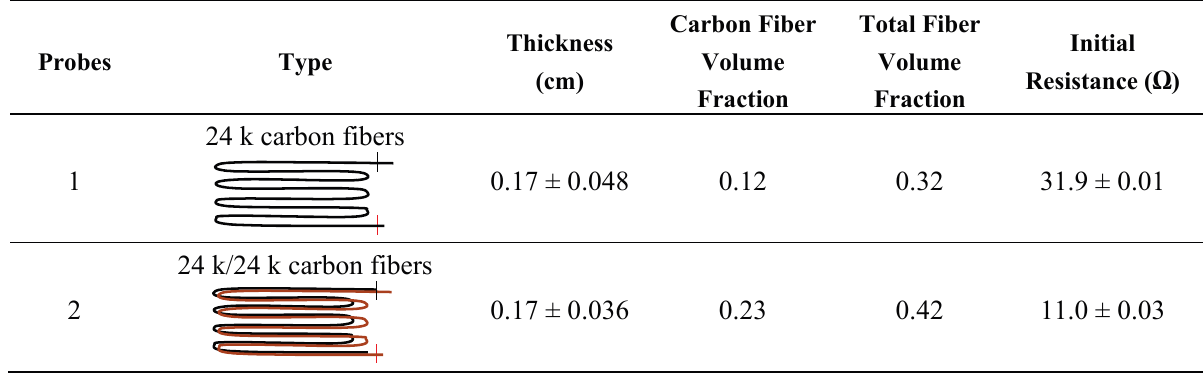
Table 3. General features of woven reinforced composite